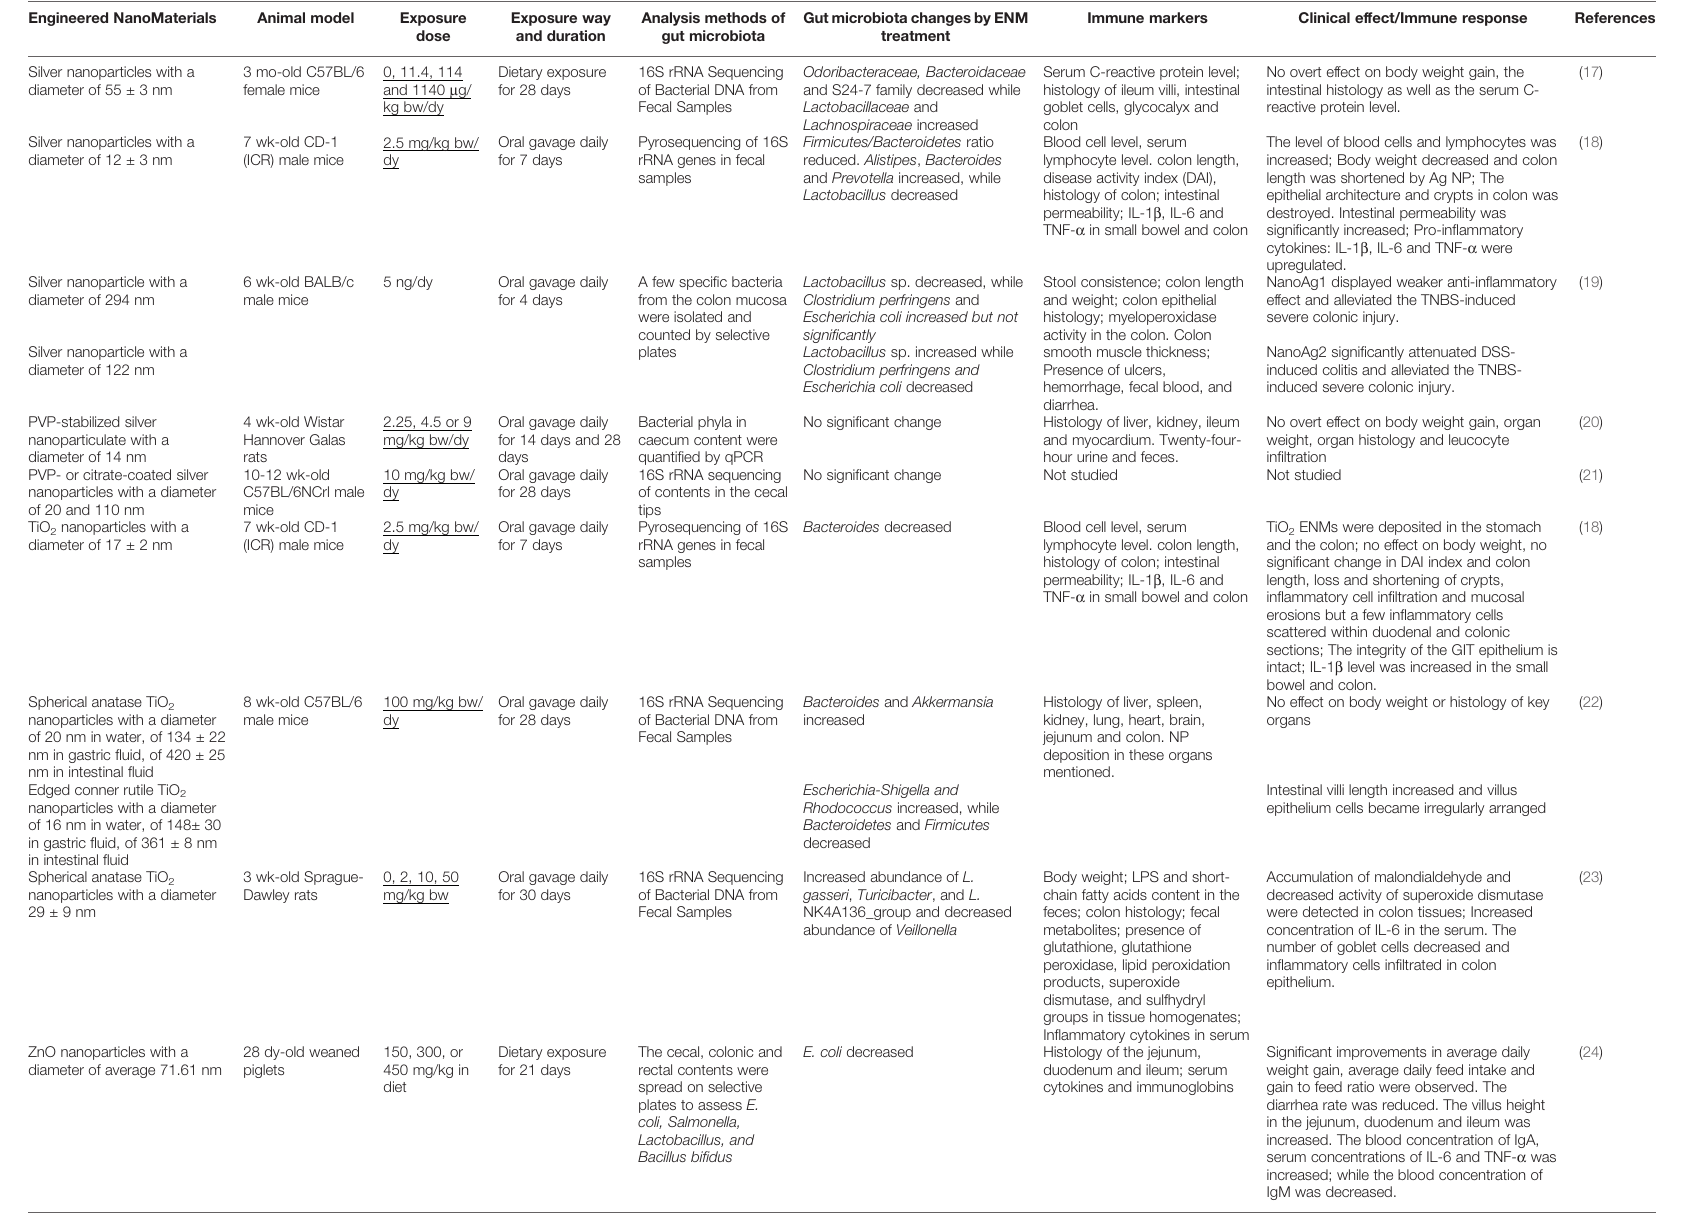
TABLE 1 | Representative in vivo assays studying the impact of ENMs on gut microbiota and subsequent in fl uences on intestinal immunity.